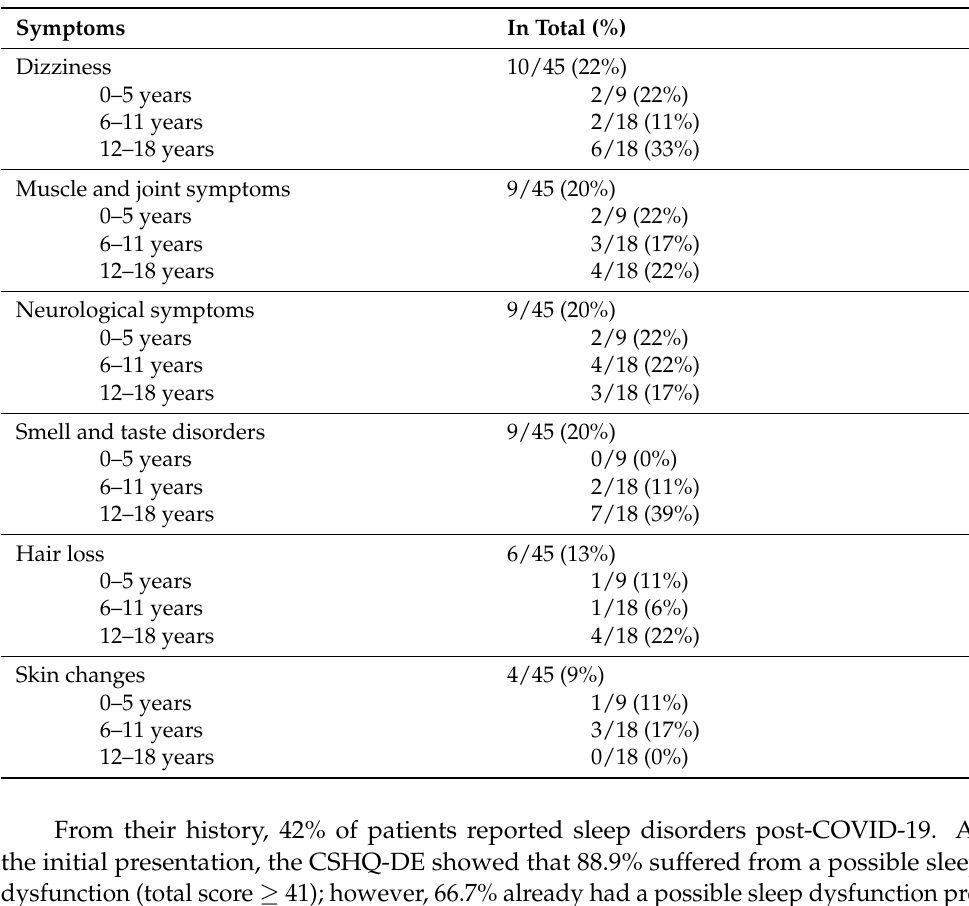
Figure 2. Subscale score “Daytime Sleepiness” pre-COVID-19 vs. post-COVID-19 initial and re- presentation: Significant increase from pre- to post-COVID-19 (13 ± 3.0 vs. 14 ± 3.2, respectively) and significant decrease at re-presentation (13 ± 3.2). Univariate ANOVA with multiple measurements and post hoc Bonferroni (*** p ≤ 0.001 and * p = 0.029, respectively).